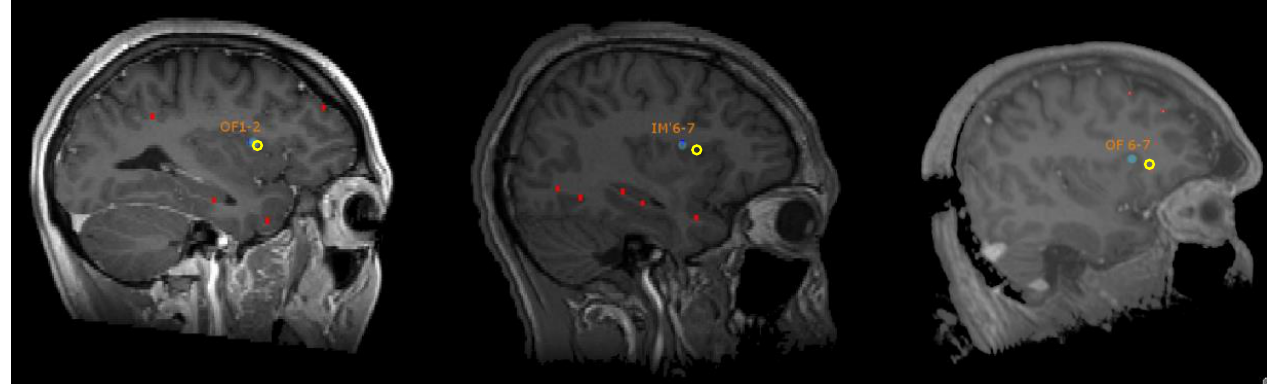
Figure 2. Localization of the contacts inducing an ecstatic aura in the operculo-insular region in three patients, in yellow. Adapted from a Figure published in Brain Stimulation 12(5) (2019), F. Bartolomei, S. Lagarde, D. Scavarda, R. Carron, C.G. Bénar, and F. Picard, The role of the dorsal anterior insula in ecstatic sensation revealed by direct electrical brain stimula- tion, page 1123, Reproduced with permission from Elsevier.